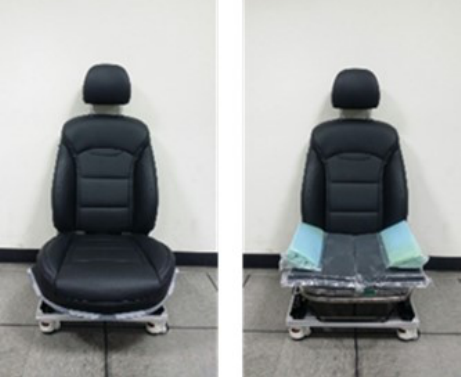
Figure 9. Air-packed, cell-integrated type of SSA seats system, with ( left ) and without ( right ) seat